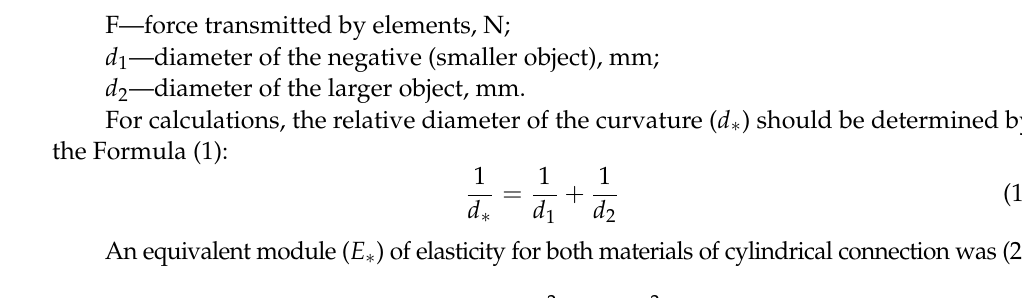
Figure 3. ( a ) Geometric definition of the Hertz problem; ( b ) stress between two objects in contact (without clearance).